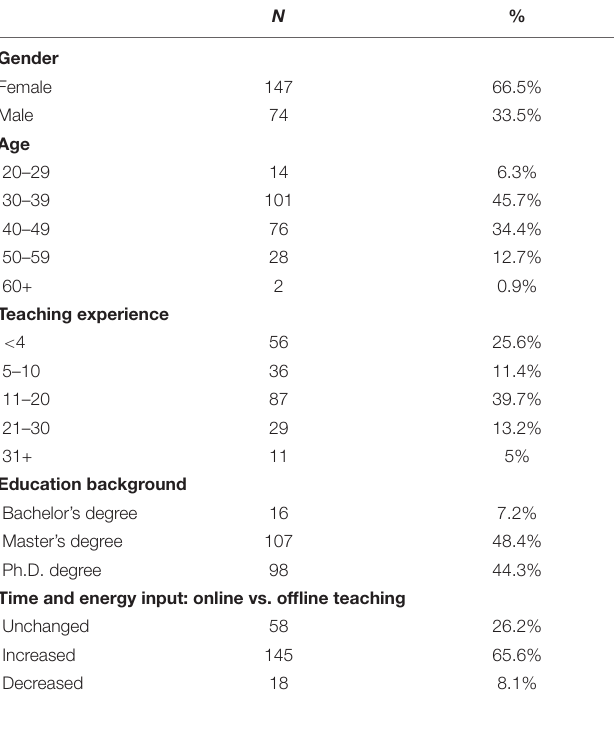
TABLE 1 | Demographic characteristics of the sample ( N = 221).